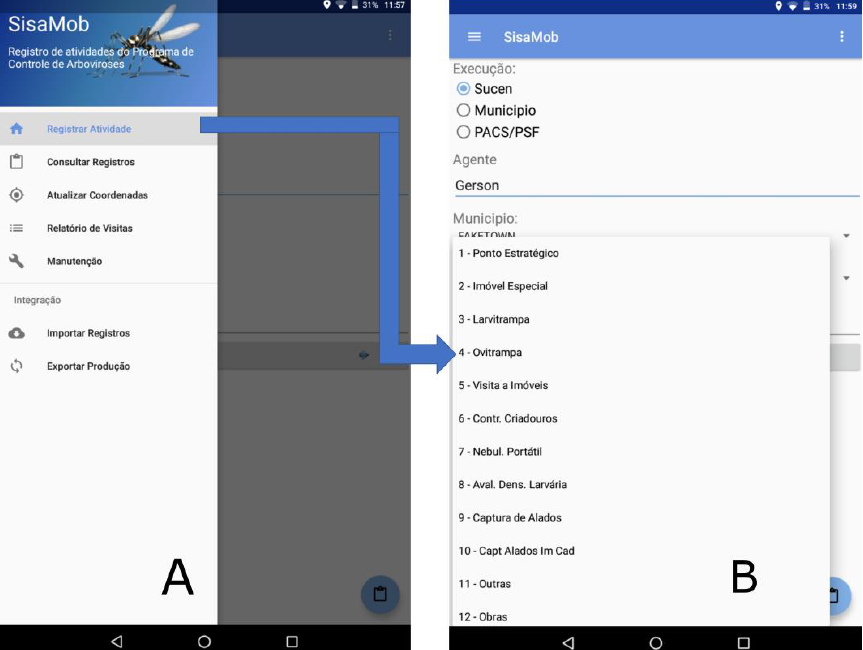
Table 1 . Characterization of the participants for the evaluation of the implementation of SisaMob in the Superintendence of Endemic Disease Control (current Pasteur Institute), 2019.